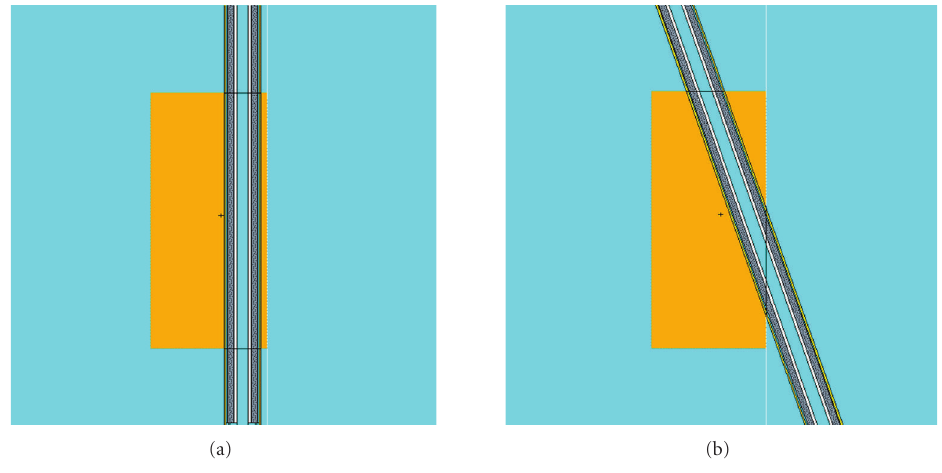
Figure 9: 2D HELIOS and 3D MCNP5 models.